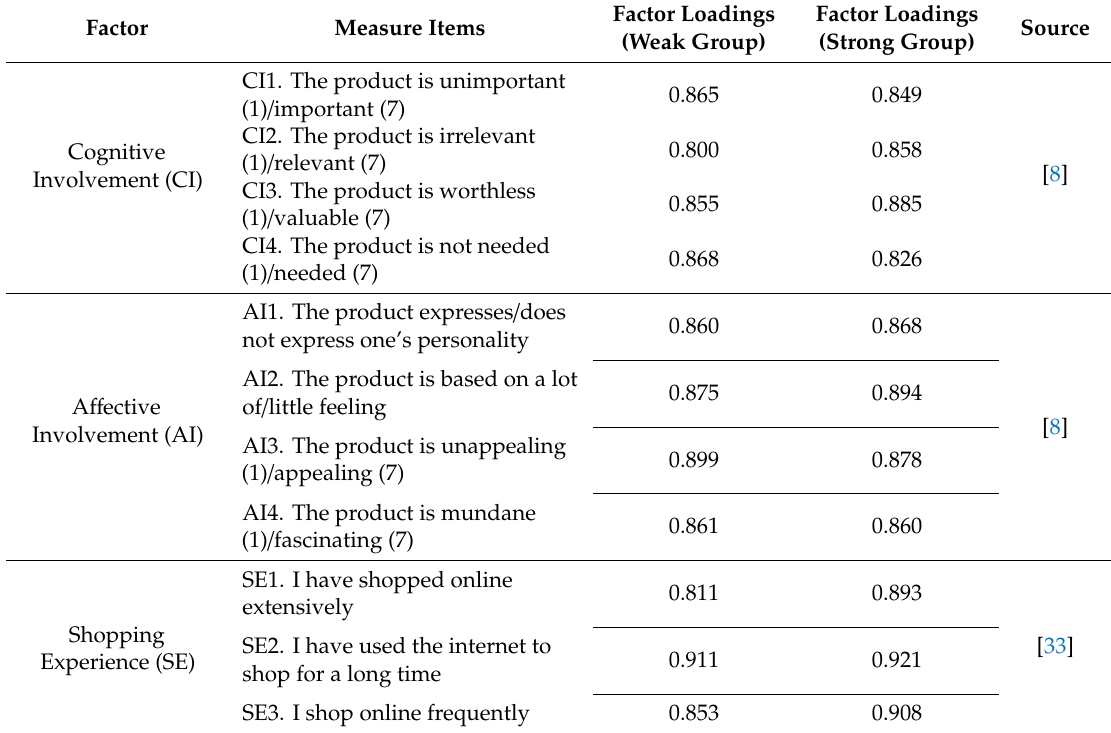
Table 1. Construct